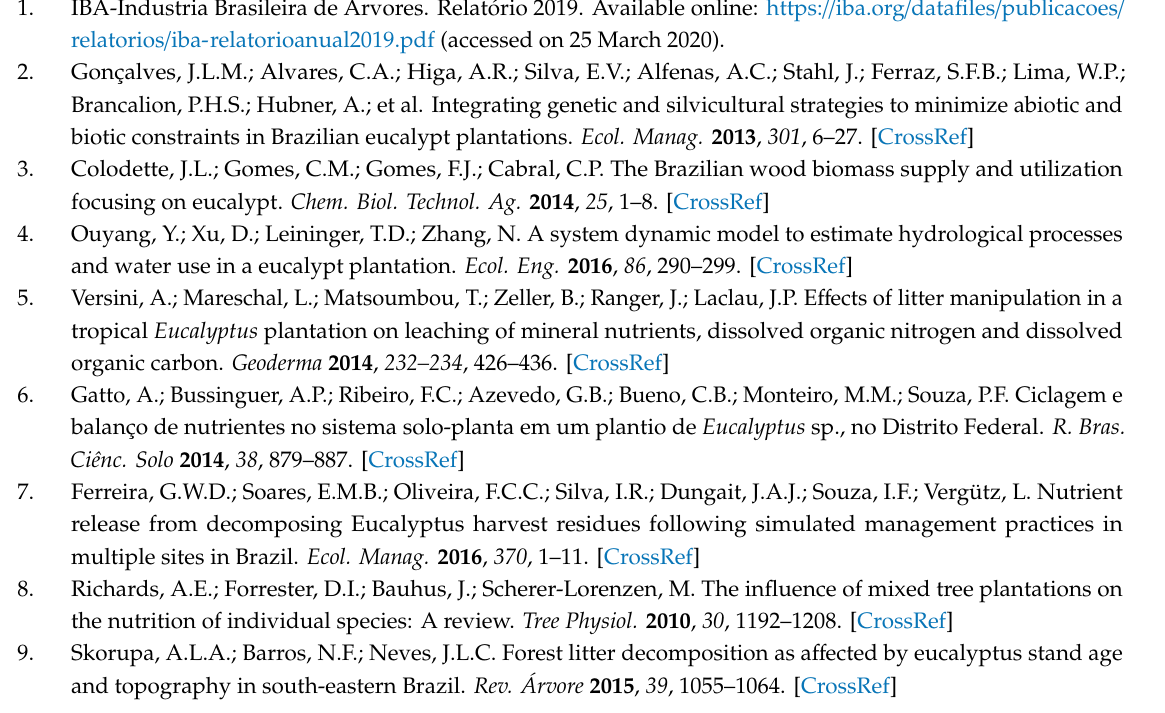
Table S1: Parameters obtained from the forest inventory of 40 plots in eucalypt stand, Table S2: Compartment’s weight of the felled trees in eucalypt stand, Table S3: Nutrient estimating from trees components and according 40 plots in eucalypt stand, Table S4: Mean of roots data and nutrients according 9 diameter categories in eucalypt